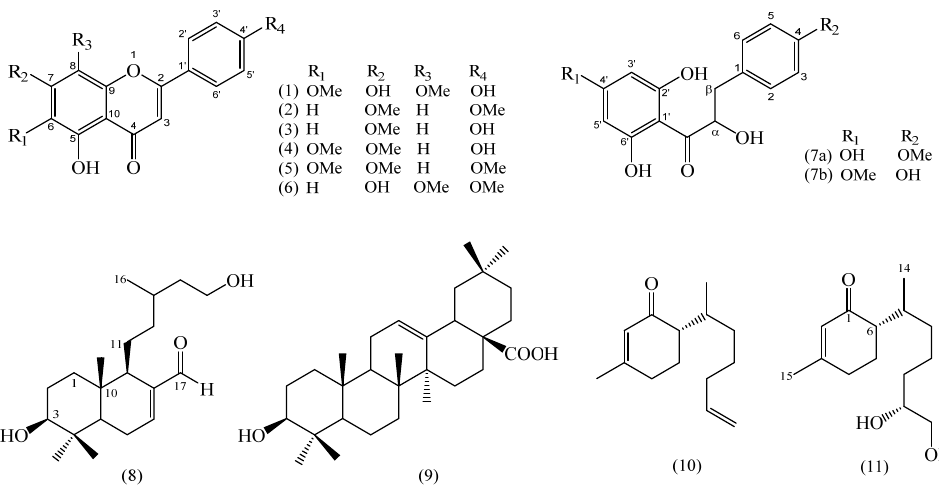
Figure 5. Structures of compounds isolated from Baccharis species ( B. trinervis , B. prunifolia , and B. zumbadorensis ). New compounds isolated from Baccharis spp.: 4 ′ -Methoxy- α -hydroxydihydrochalcone